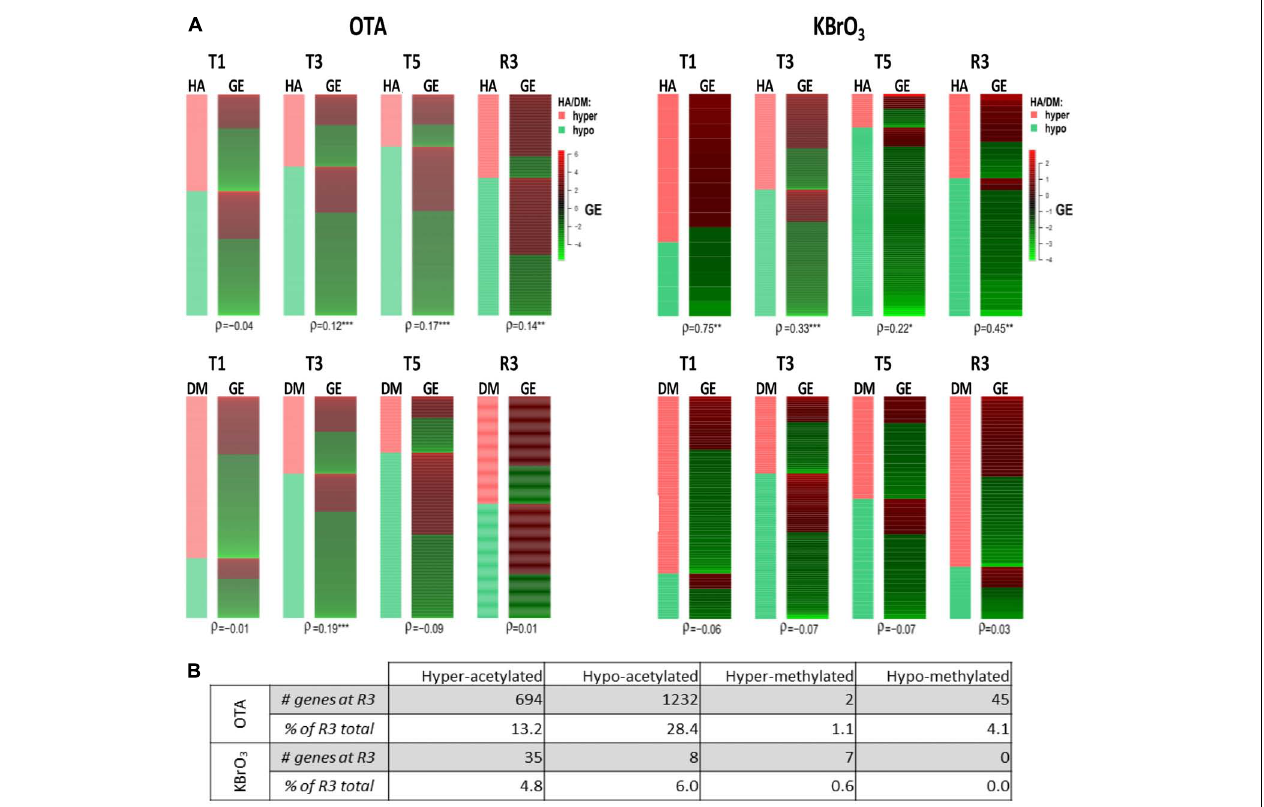
FIGURE 3 | Correlation of epigenetic modifications to mRNA expression changes and persistence after washout and recovery in OTA- and KBrO 3 -treated cells. (A) - Correlation between epigenetics and gene expression was tested at each time point with Spearman’s rank correlation coefficient ( ρ ). Strong correlation between histone acetylation (HA) or DNA methylation (DM) and mRNA gene expression (GE) renders a coefficient close to 1, strong anti-correlation renders a coefficient close to -1. A p -value for statistical significance of the correlation was also calculated and is indicated by ∗ p < 0.05, ∗∗ p < 0.01, ∗∗∗ p < 0.001. (B) Persisting epigenetic modifications after compound washout and recovery period. Here, epigenetic modifications with sustained directionality at T5 and R3 for a given gene were considered persisting after treatment. Percentage of persistent modifications was calculated as the percentage of modifications in the R3 datasets that were already present at T5 and modified in the same direction compared to time-matched control; e.g., for OTA, 694 genes corresponding to 13.2% of hyper-acetylated genes at R3 were already hyper-acetylated at